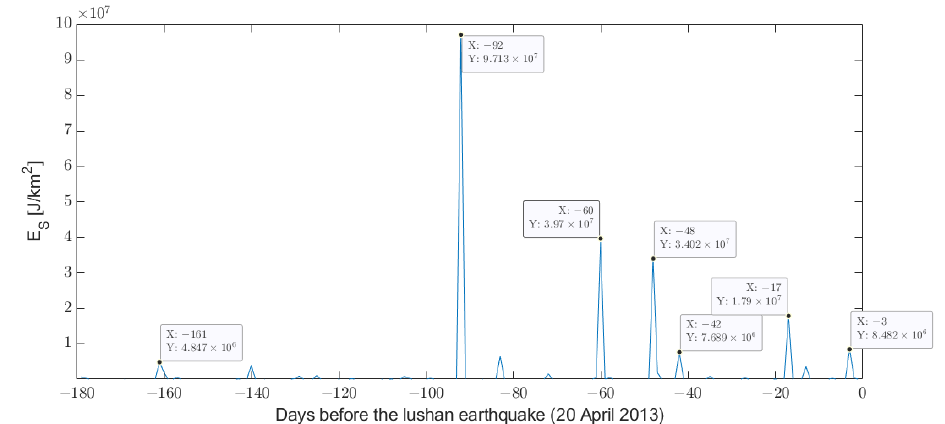
Figure 8. E s parameter calculated from the earthquake catalog six months before the Lushan earthquake. Only the events equal to or greater than the completeness magnitude of 0.6 were considered in the graph.